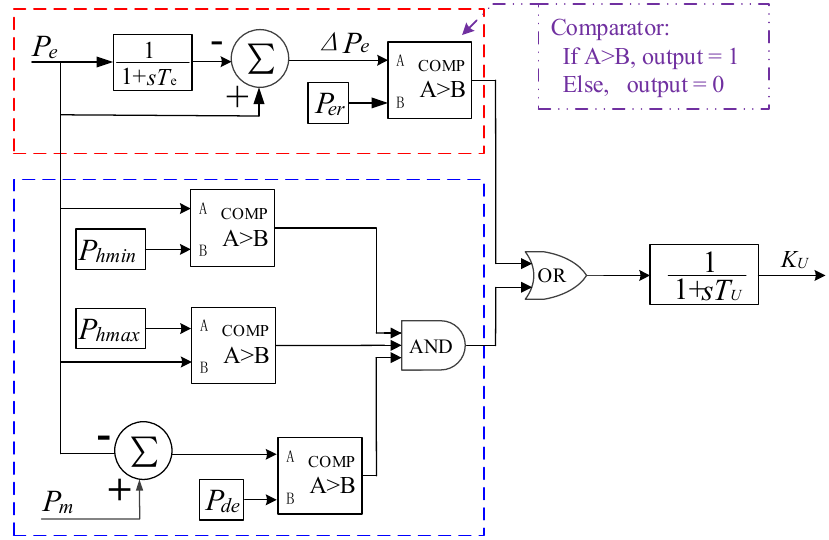
Figure 8. The model of the load rejection controller of the FCB